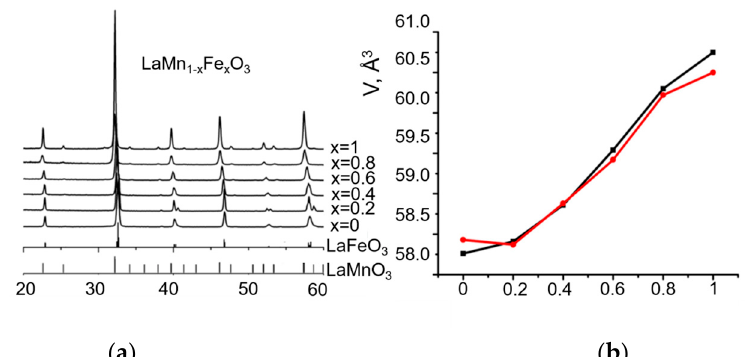
Figure 1. X-ray diffraction patterns of LaMn 1 − x Fe x O 3 perovskites before catalytic testing ( a ) and the unit cell volume in dependence x before (- ■ -) and after (- ● -) testing ( b ) in methane oxidation.